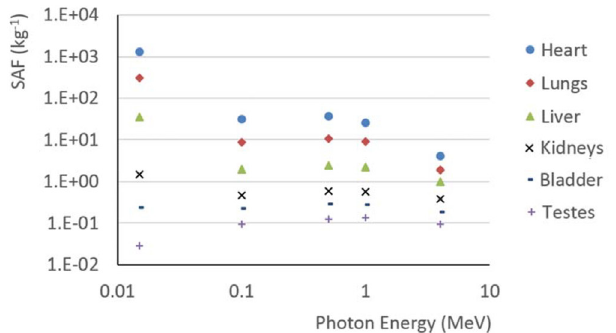
FIGURE 2 - Graphic of Specific Absorbed Fractions versus photon energy for some of DM_BRA organs. The photon source was positioned at the heart. The relative errors were below 5%.